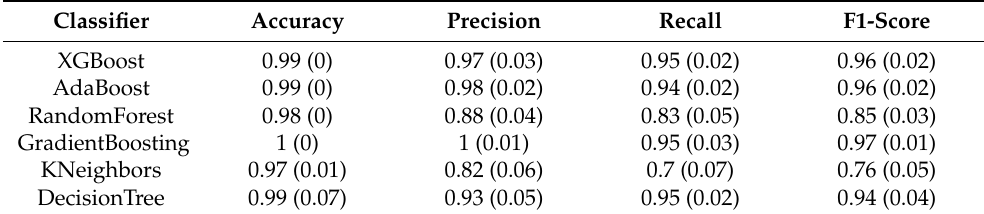
Table 5. Models’ performance for Gaussian Spreading (standard deviation in brackets).